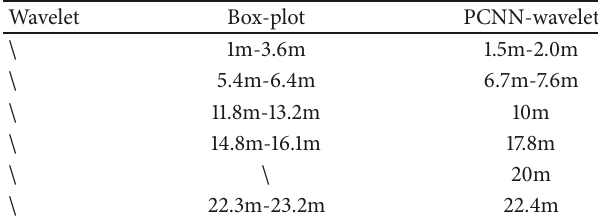
Table 2: Comparison of abnormal point detection